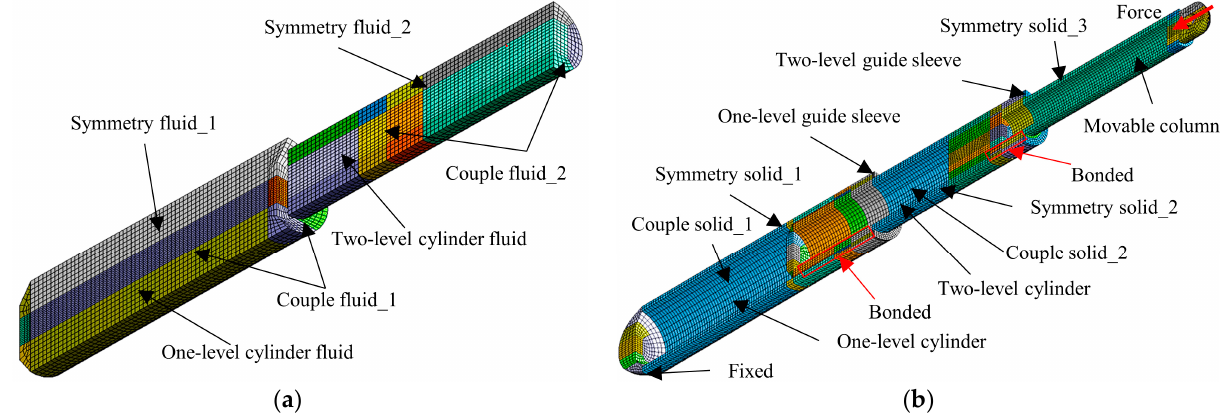
Figure 10. ( a ) Mesh of the column fluid domain. ( b ) Mesh of the column solid domain.